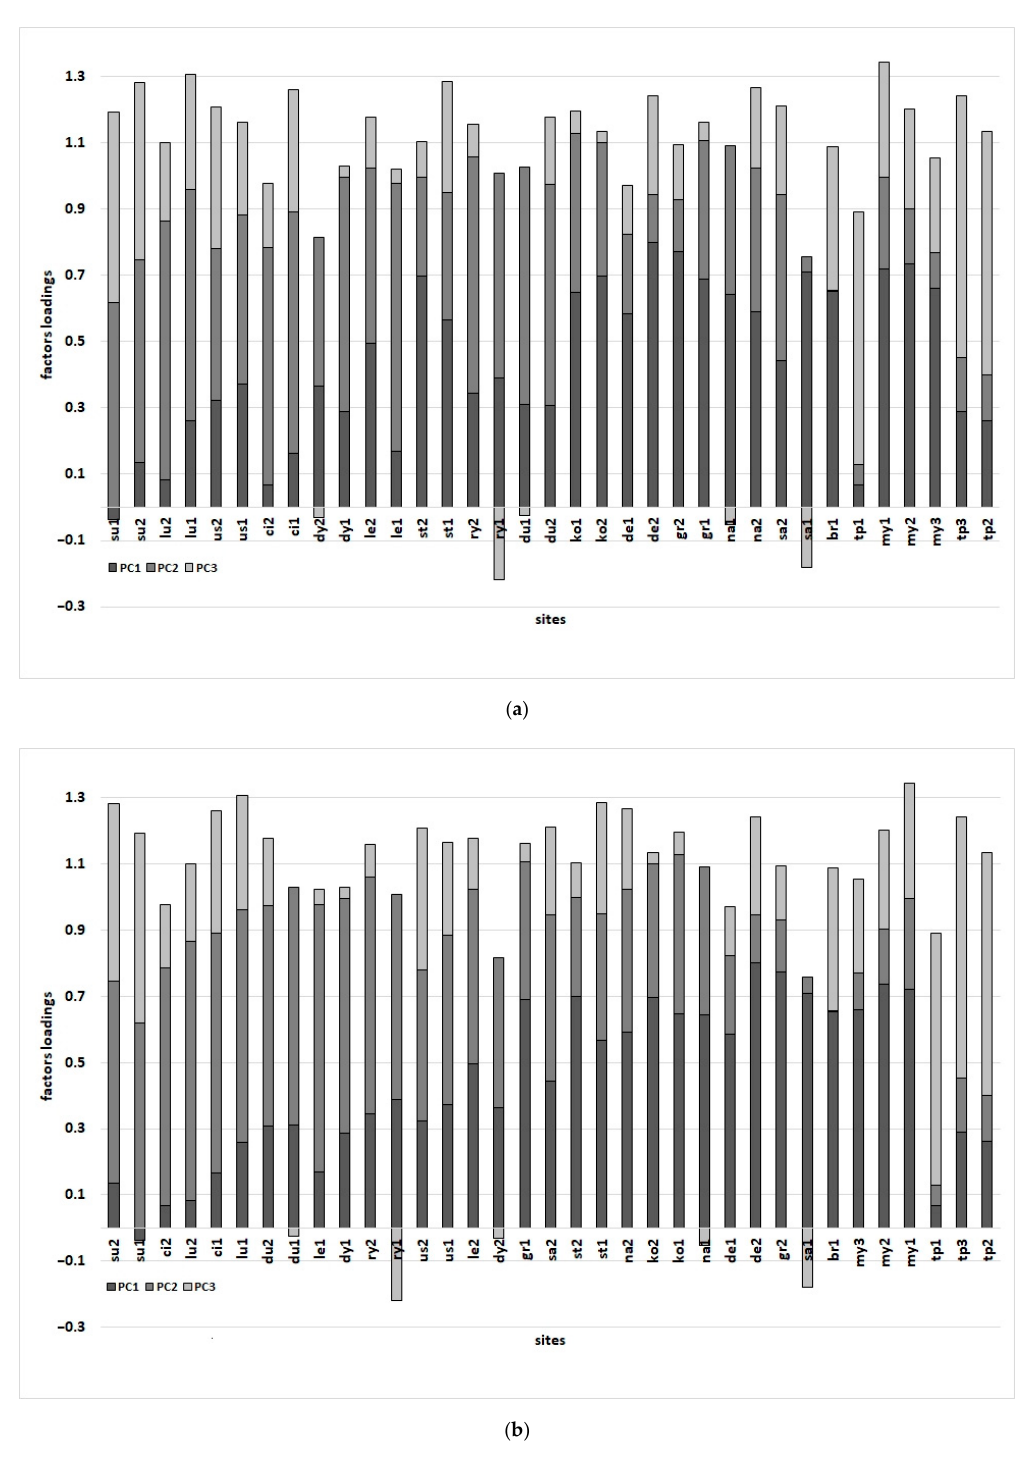
Figure 3. Results of principal component analysis (PCA) analysis. The share of the first three principal components (PCs) in each site are presented. ( a ) East to West site order; ( b ) site order according to clustering.